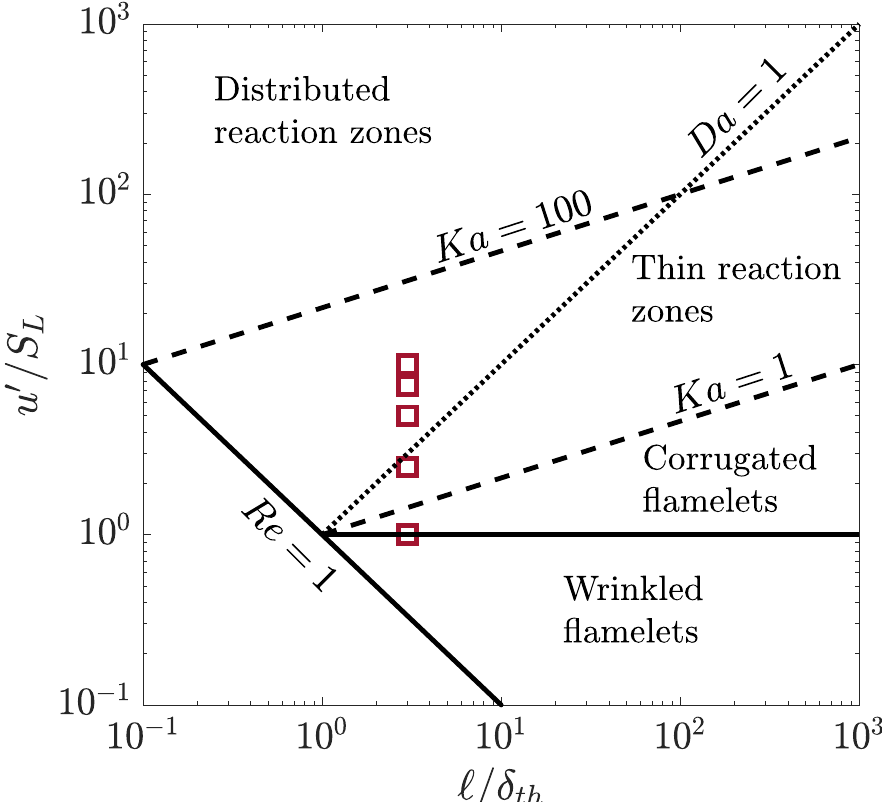
Figure 1. The cases considered in this analysis on a Borghi-Peters